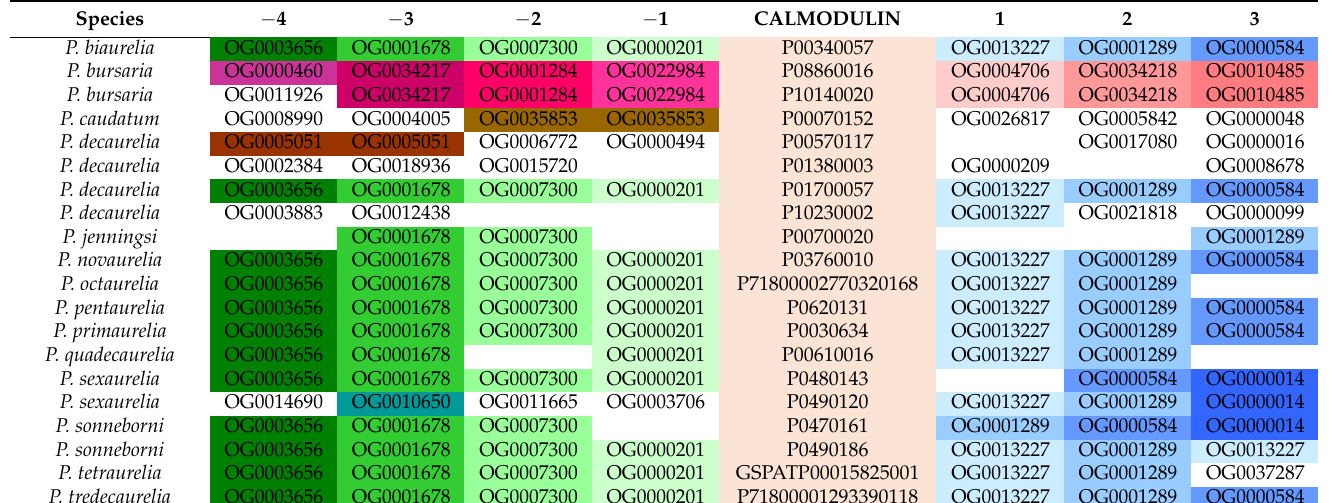
Table 3. Synteny around CaMs in Paramecium species. The sequences classified as TRUE in Table 2 were searched for in ParameciumDB and the corresponding upstream and downstream genes local- ized and assigned to its orthogroup. The column CALMODULIN indicates the accession number of the corresponding CaMs in the different species. To help with visualization, some orthogroup are marked by a different color. Numerals marked with a minus indicate upstream genes, while the other numerals indicate downstream